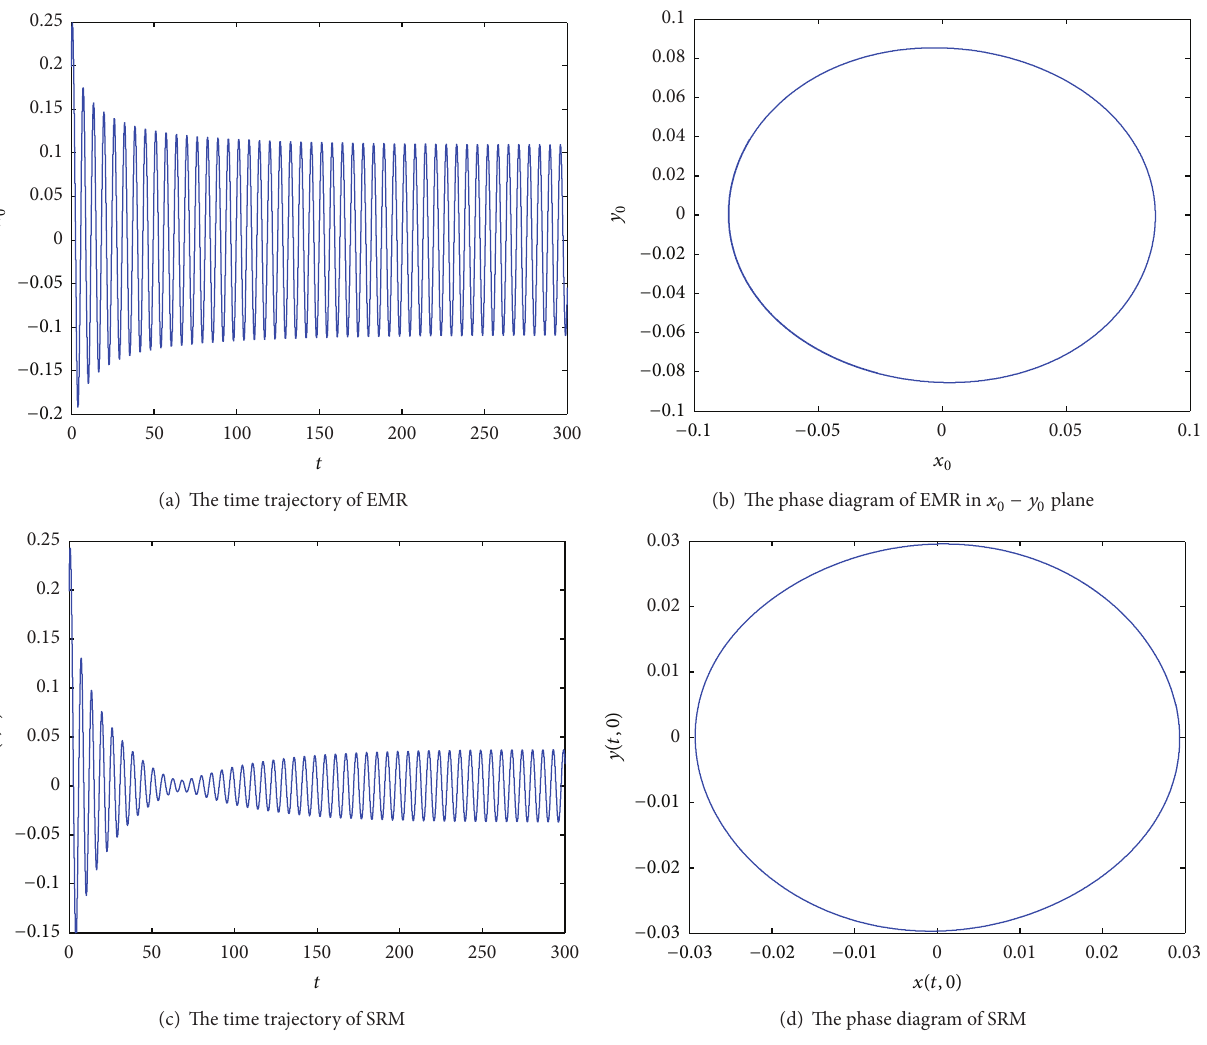
Figure 3: The time trajectories and phase diagrams for 𝑢 = −0.01